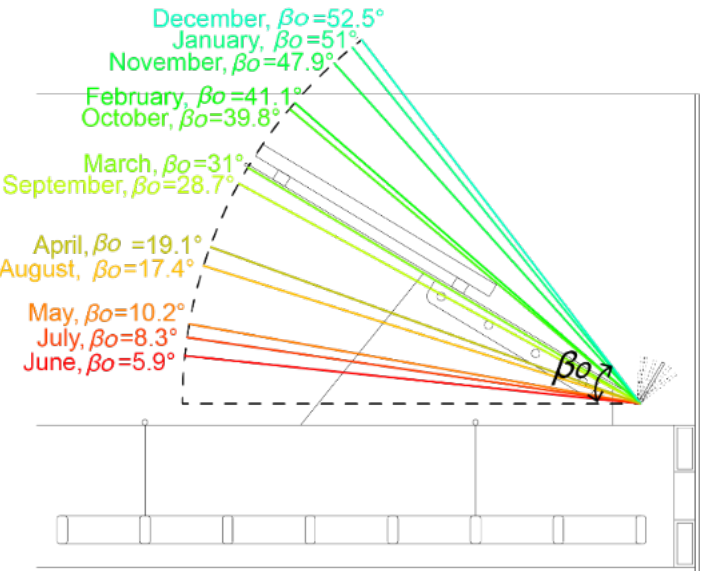
Figure 8. Flexible installation system according to the optimal tilt angle ( βо ) of solar panels from January to December, maximizing the solar energy generation.